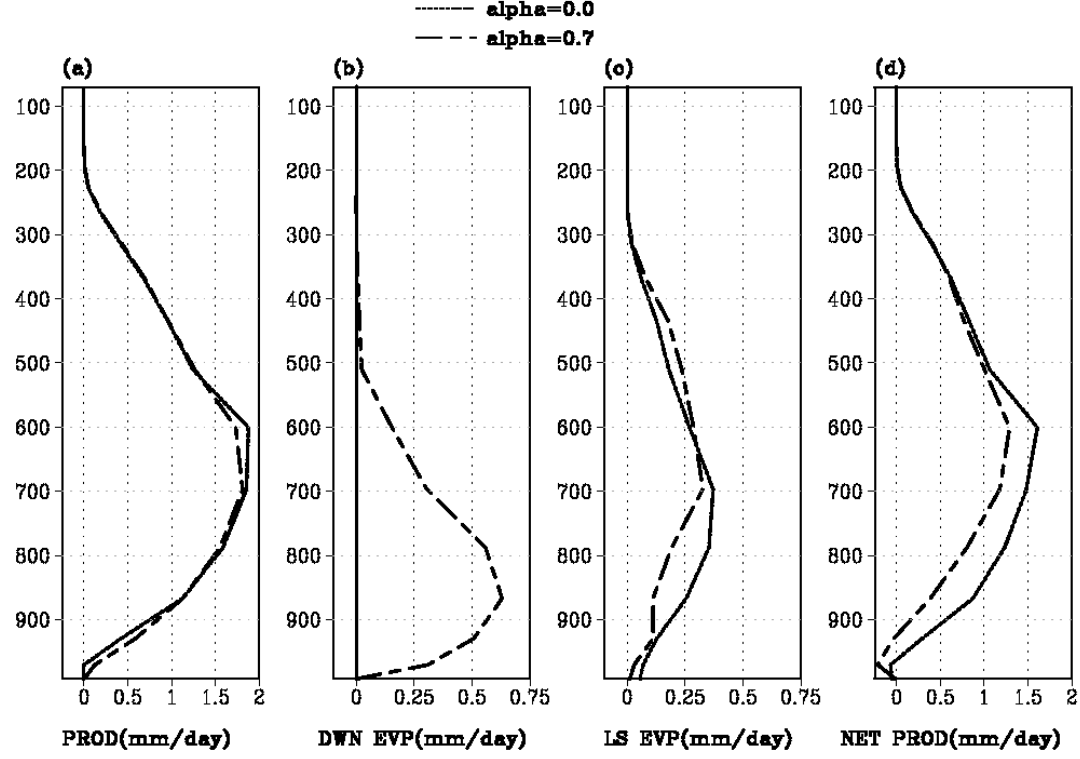
Fig. 3. Vertical profile of the area averaged (0 to 360 and 7 ◦ S to 7 ◦ N), time mean, quantities for α =0 and α =0.7 (a) deep convective precipitation production rate (mm/day), (b) evaporation of the deep convective precipitation inside the downdrafts (mm/day), (c) grid scale evaporation of the deep convective precipitation (mm/day), (d) net deep convective precipitation production rate